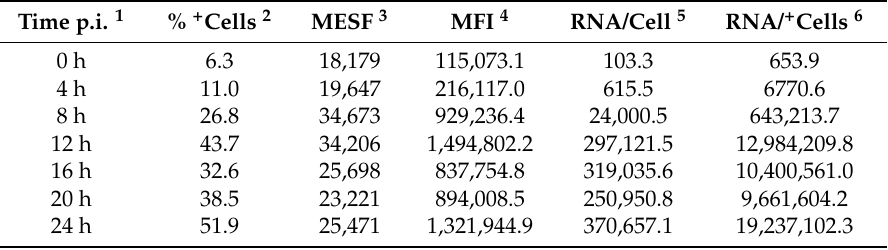
Table 4. Time course experiment: VP2 production and RNA synthesis.